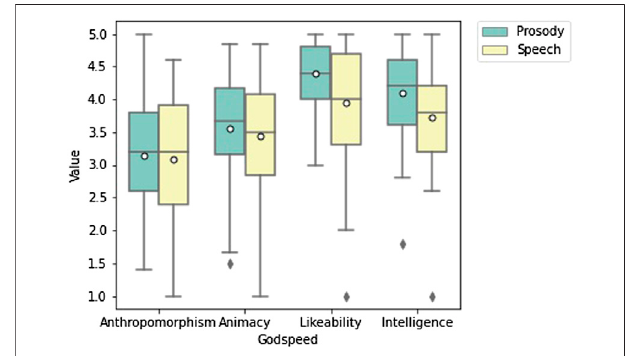
FIGURE 7 | Box plot of Godspeed Metrics. Likeability and Intelligence are signi fi cant p (cid:1) 0.011 and p (cid:1)